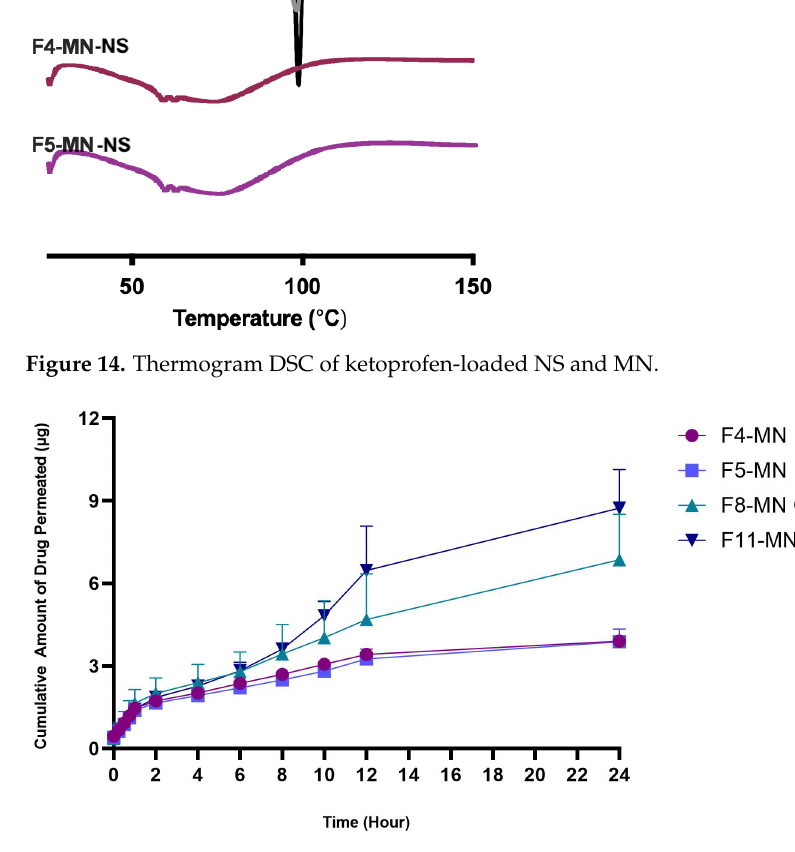
Figure 15. The cumulative amount of drug permeated in vitro using Franz diffusion cells for 24 h from DMN loaded with nanosuspension and co-grinded ketoprofen (n = 3, mean ± SD, p > 0.05).